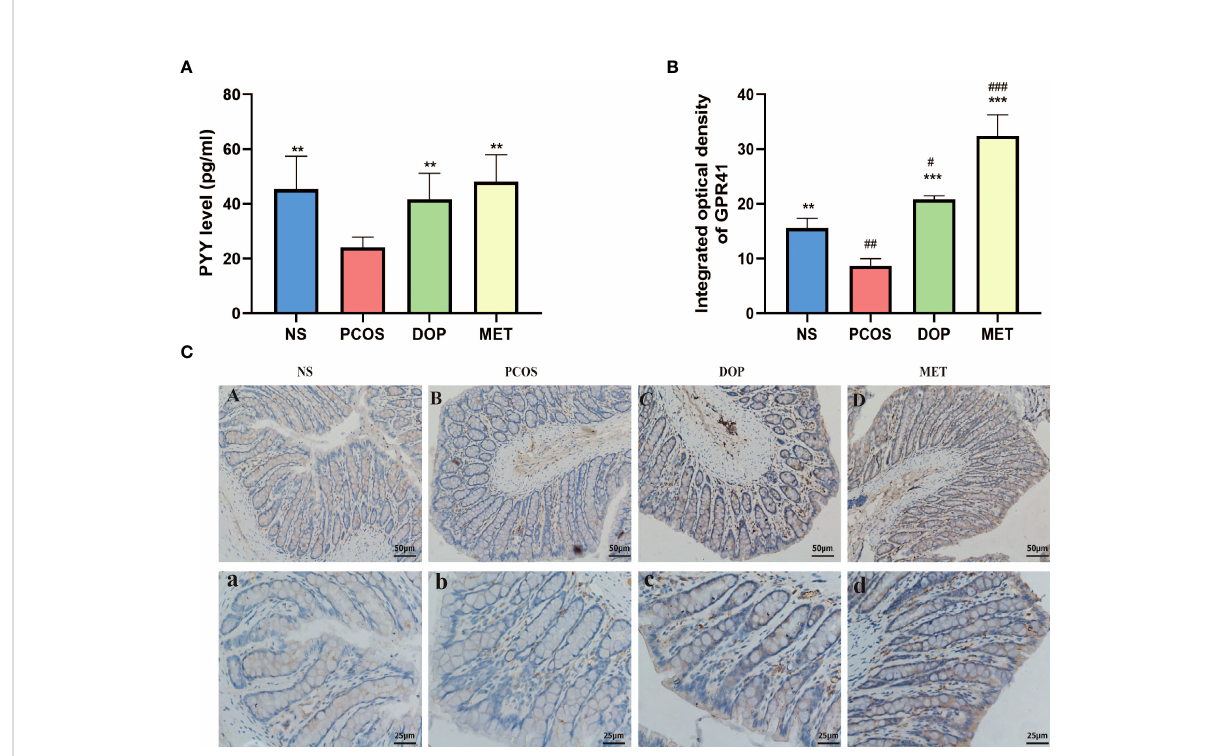
FIGURE 9 Effects of DOP treatment on gut – brain mediators. (A) Serum levels of PYY, n = 5. (B-C) Colonic GPR41 expression, location, and integrated optical density, n = 3, scale bar = 50 and 25 m m. Note: compared with the PCOS group, ** p < 0.01, *** p < 0.001; compared with the NS group, # p < 0.05, ## p < 0.01, ### p <